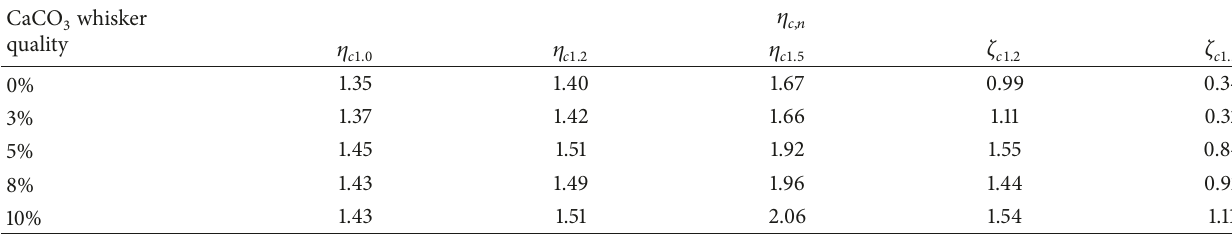
Table 4: The toughness index and capability coefficients